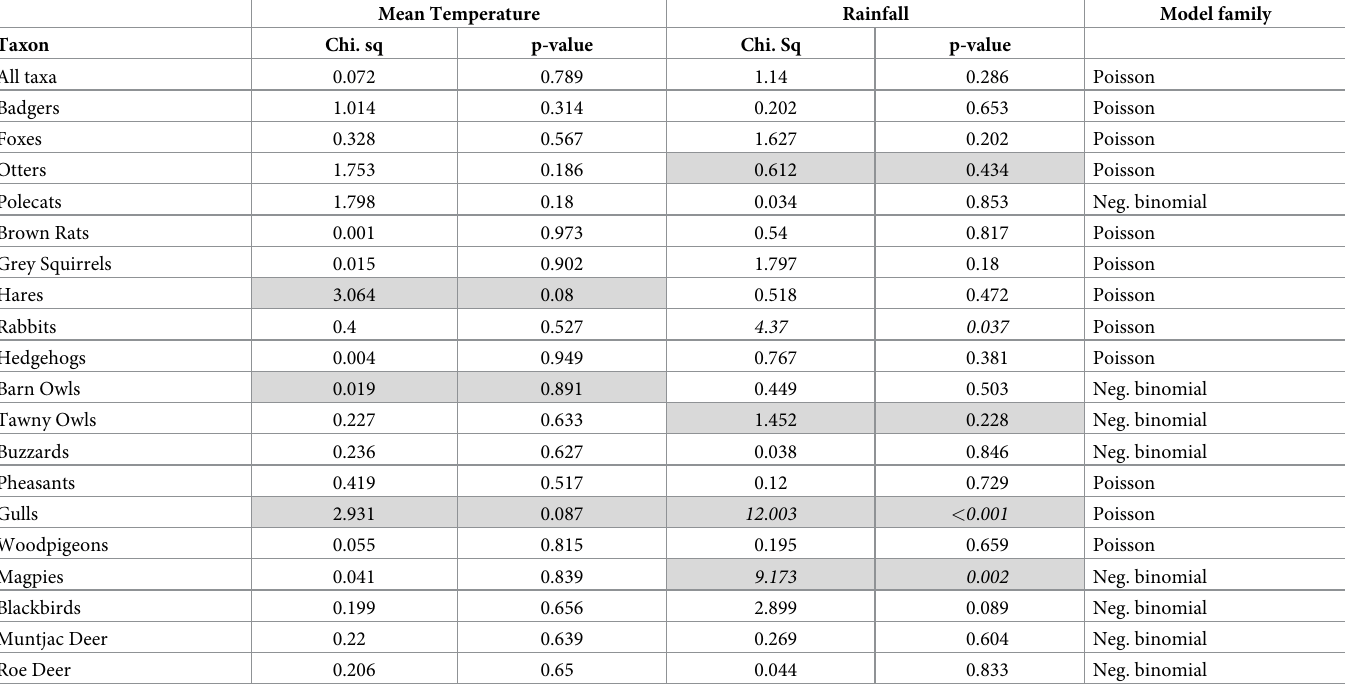
Statistically significant (and marginal) values are shaded; italics indicate a significant negative relationship, bold a significant positive relationship. In all instances, the degrees of freedom were